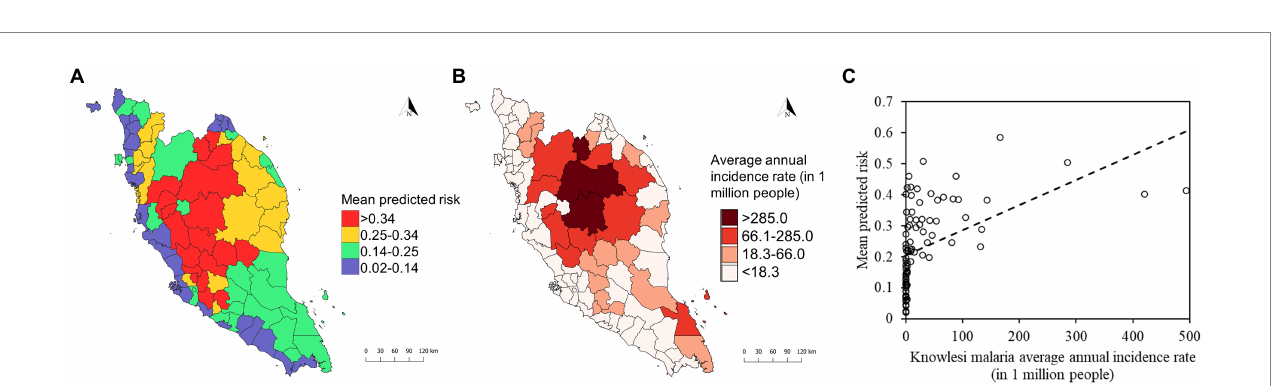
FIGURE 9 (A) District-level mean predicted risk of human knowlesi malaria based on XGBoost output. (B) Average annual incidence rate of knowlesi malaria from 2011 to 2019 by district. Color gradations for maps in (A,B) were determined using Jenks natural breaks. (C) Correlation plot shows statistically significant positive correlation (Spearman’s correlation coefficient ρ = 0.76, value of p < 0.001) between mean predicted risk and knowlesi malaria average annual incidence rate (in 1 million